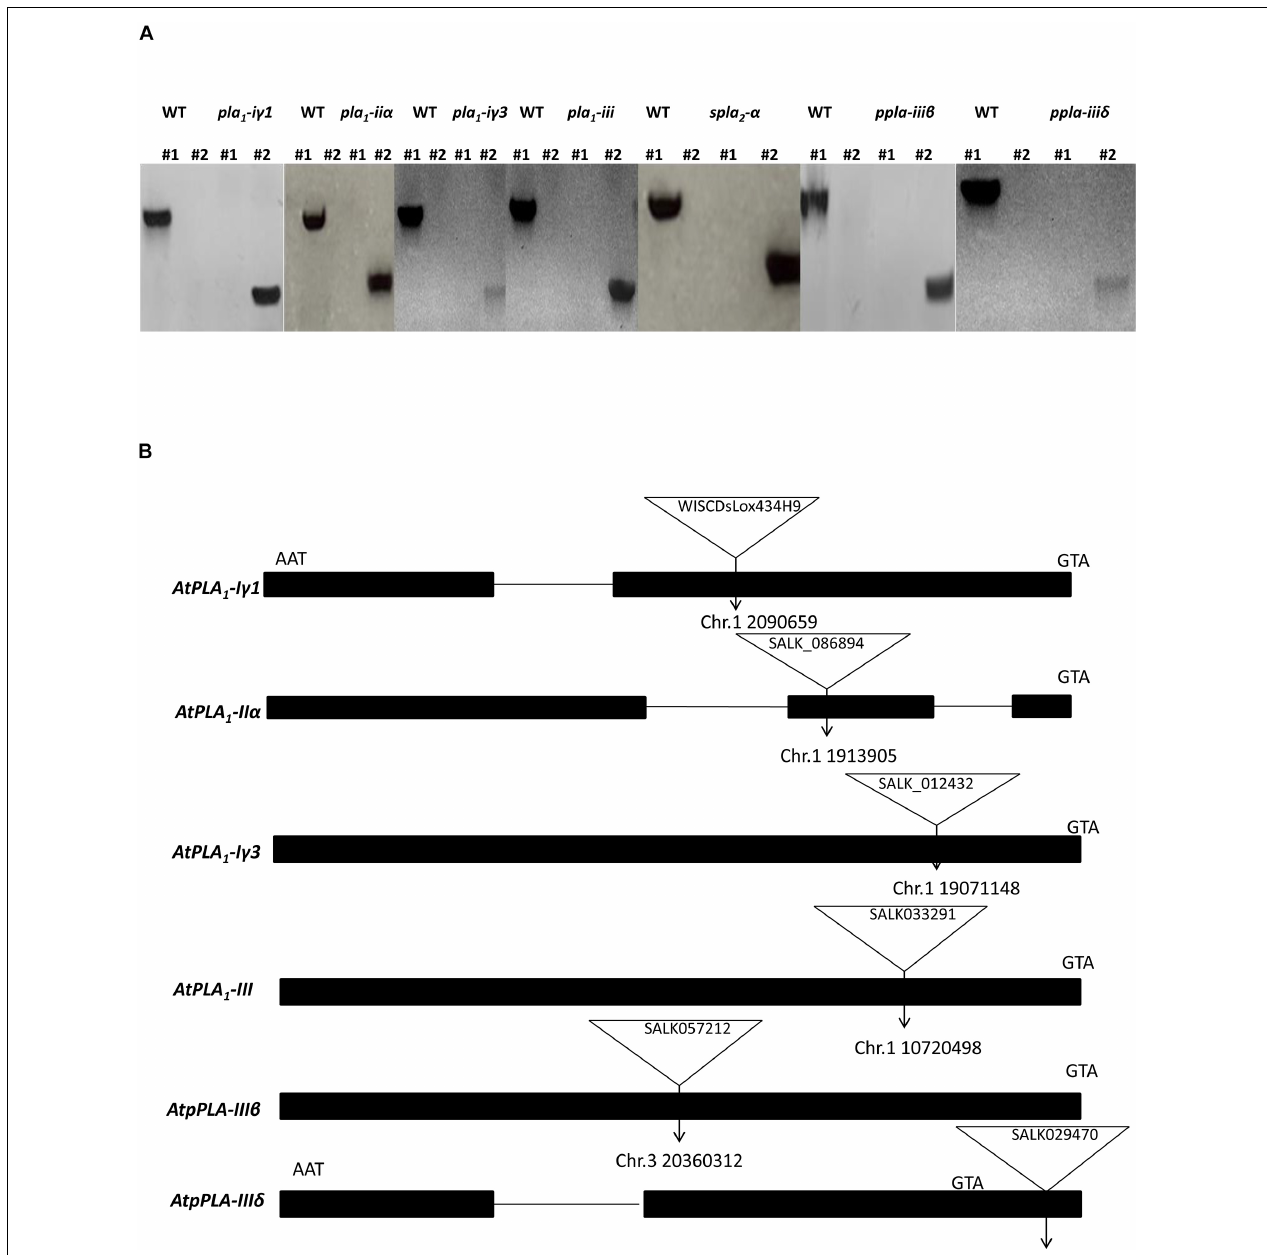
FIGURE 1 | Identification and characterization of Arabidopsis T-DNA insertion lines. (A) Identification of T-DNA insertion lines by PCR. LP and RP primers are located at the left and right sides of T-DNA insertion, respectively. LBb1.3 and P745 are used as flanking primers for SALK and WiSC lines, respectively. In each gel picture #1 is the PCR sample with primers LP + RP and #2 is the PCR sample with primers LB1.3/P745 + RP. (B) Schematic diagrams of the positions of T-DNA insertions in PLA single mutant alleles. Start and stop codons are